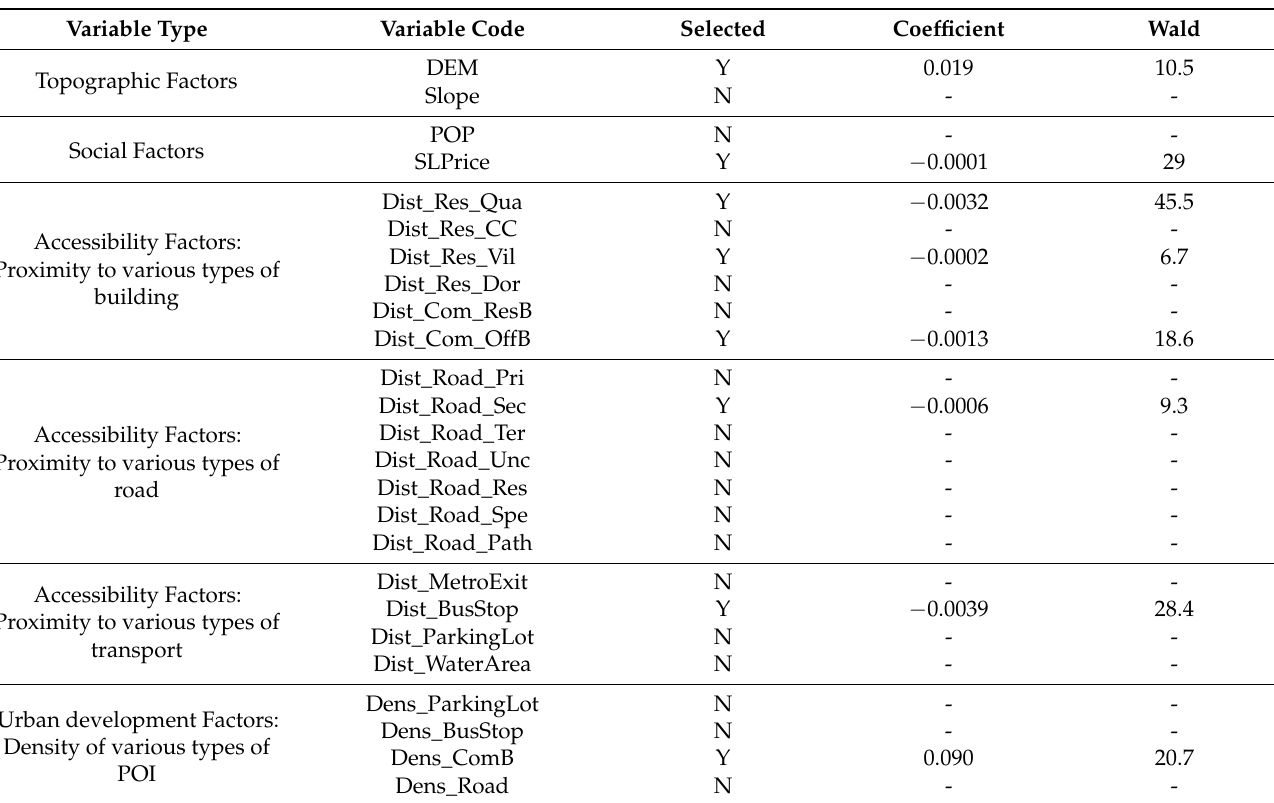
Table 7. Coefficient of the best explanatory variable combination in the standard LR